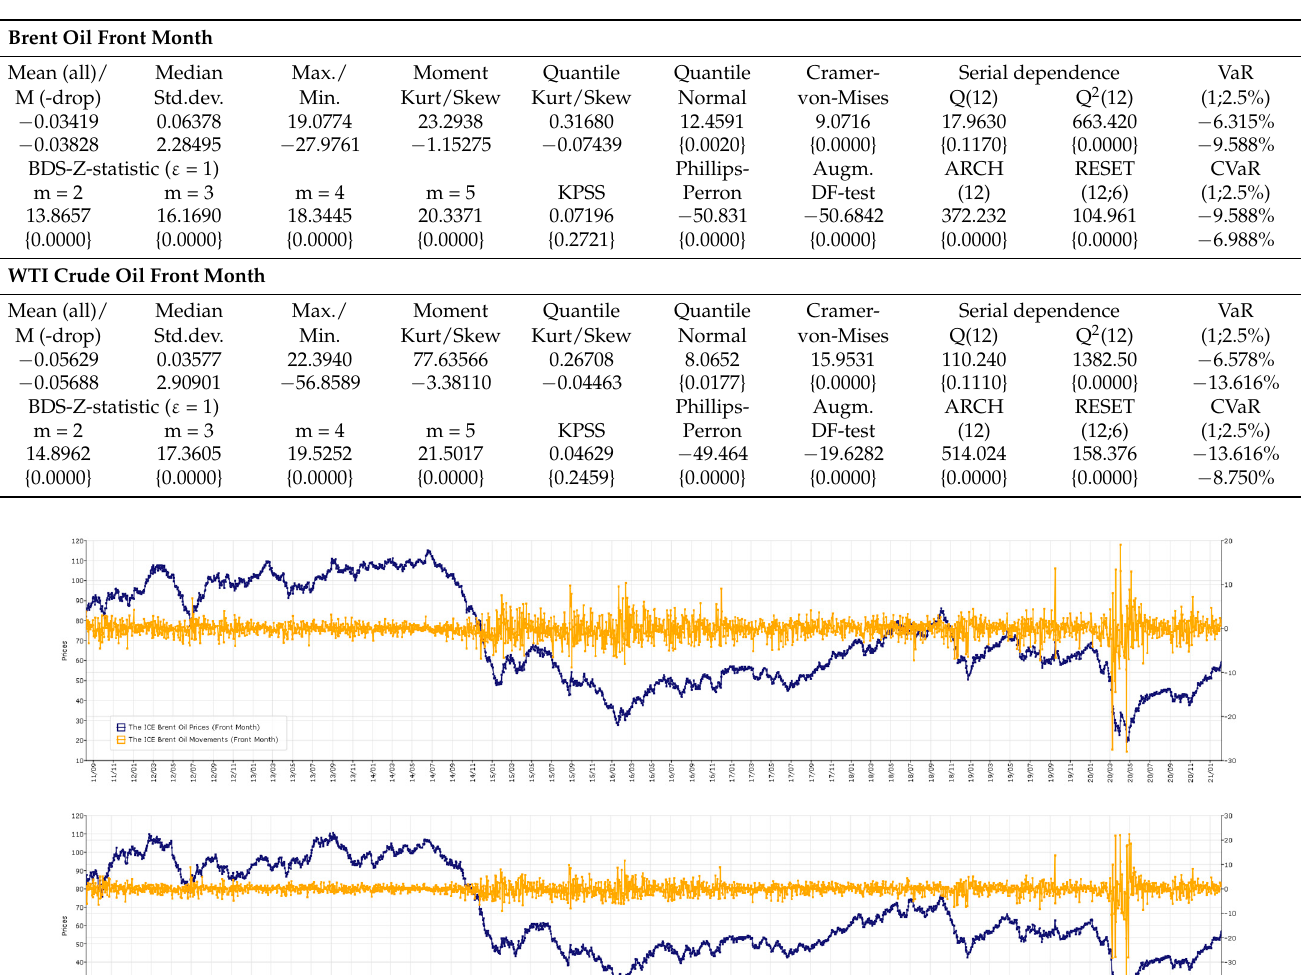
Table 1. Characteristics for Brent oil and WTI Crude oil Front Month Contracts 2011–2021.